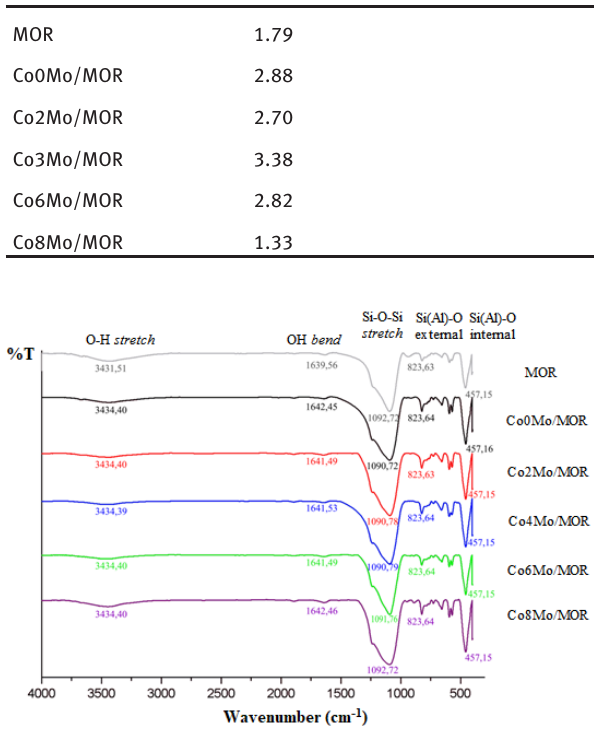
Table 3: Total acidity of MOR and CoMo/MOR catalysts.